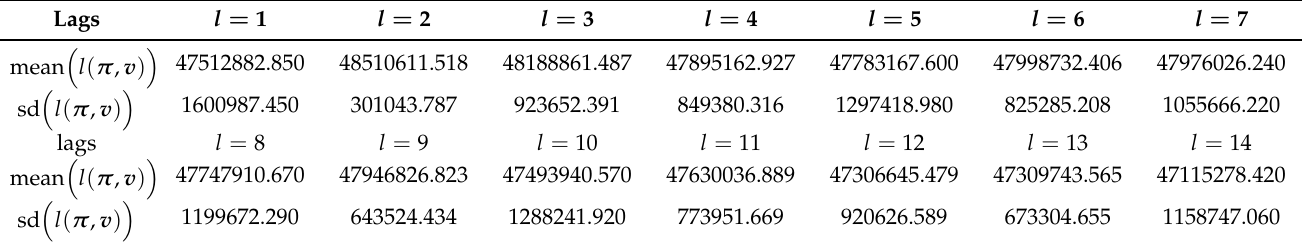
Table 1. Different time lags and the corresponding penalized log-likelihood values shown with the mean and standard deviation (sd). Thirty different initial processes for each lag are randomly implemented. The corresponding mean and sd are calculated based on 30 repetitions.